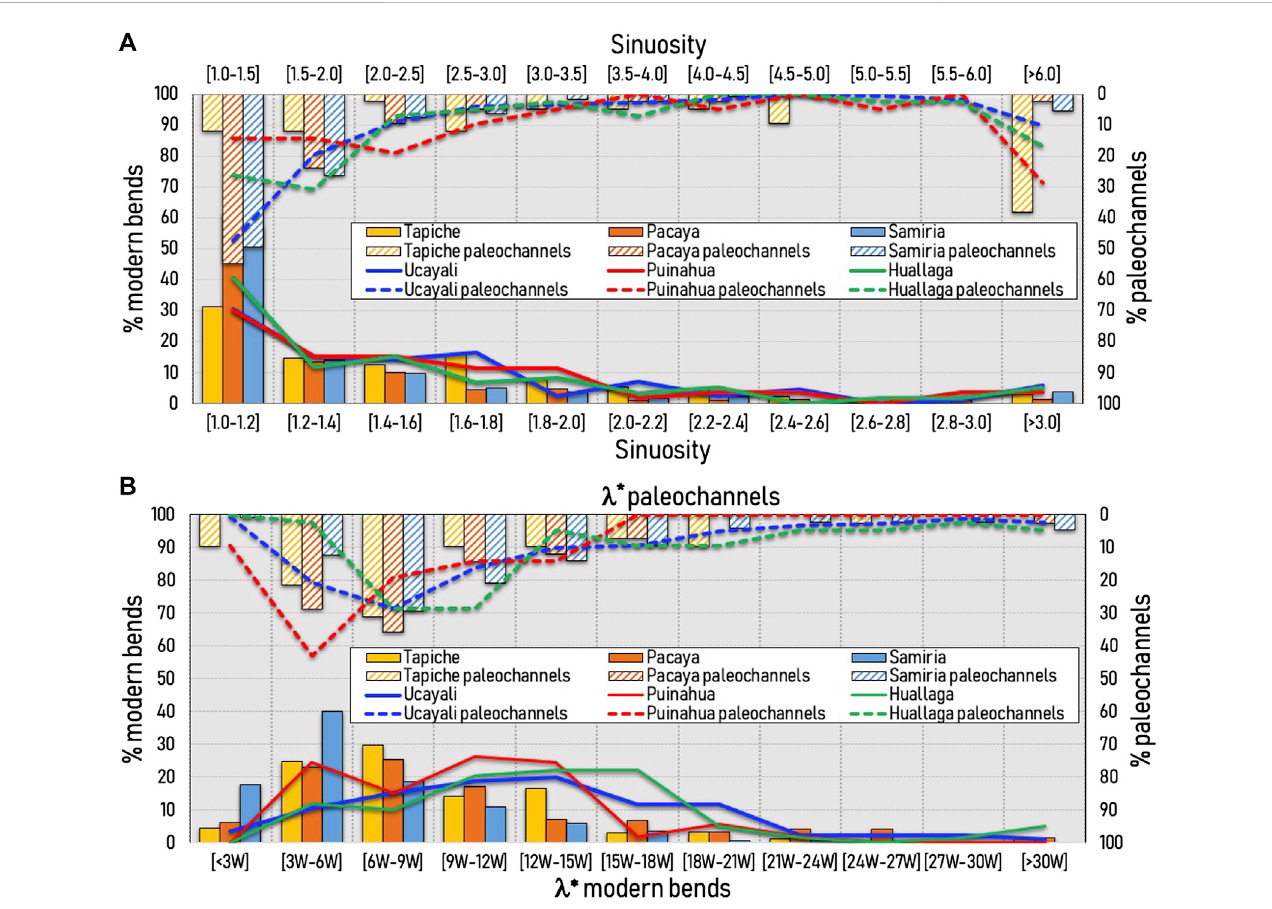
FIGURE 7 (A) Sinuosity and (B) arc-wavelength of the rivers in the P-S wetland (modern and paleochannels). The percentage plots are normalized using the total amount of bends for each river. The dimensionless arc-wavelength for the modern bends is obtained using the river width for each river; however, the dimensionless arc-wavelength for the paleochannels is obtained using the Ucayali ’ s width (except for the Huallaga